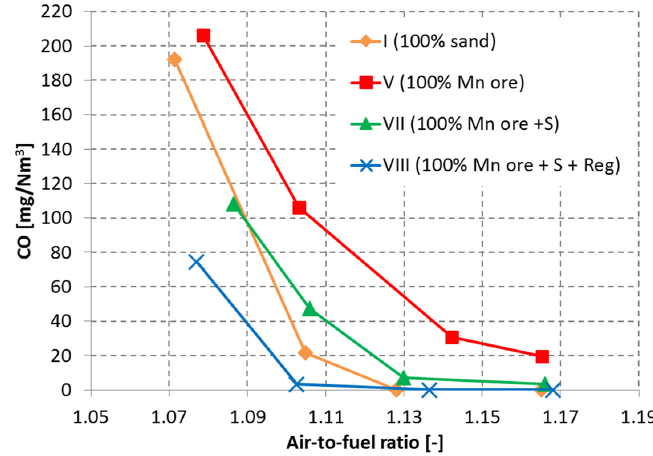
Figure 6. Measured concentrations of CO (mg/nm 3 , at 6% O 2 ) at position kh2 in the convection path as